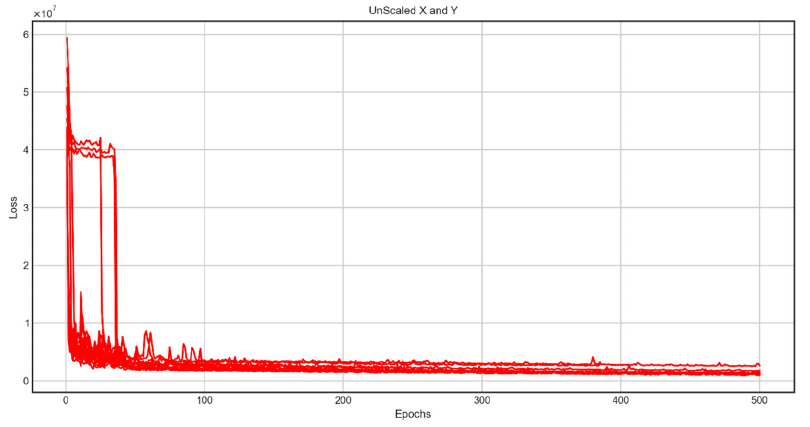
Figure 6. Loss of unscaled features (Case 1).